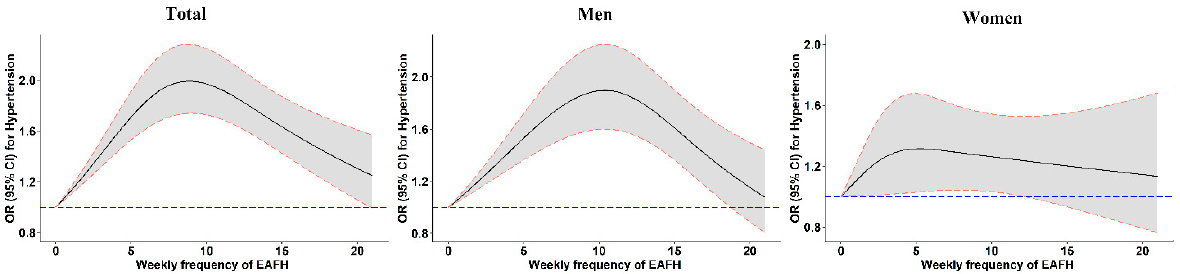
Figure 2. ORs and 95 % CIs of weekly frequency of EAFH for hypertension from restricted cubic splines. OR , odds ratio; CI , confidence interval; EAFH, eating away from home. The fully adjusted model included age, gender (only for total participants), marital status, education level, average income per month, smoking status, alcohol consumption, physical activity, abundant vegetable and fruit intake, high-fat diet, and family history of hypertension.